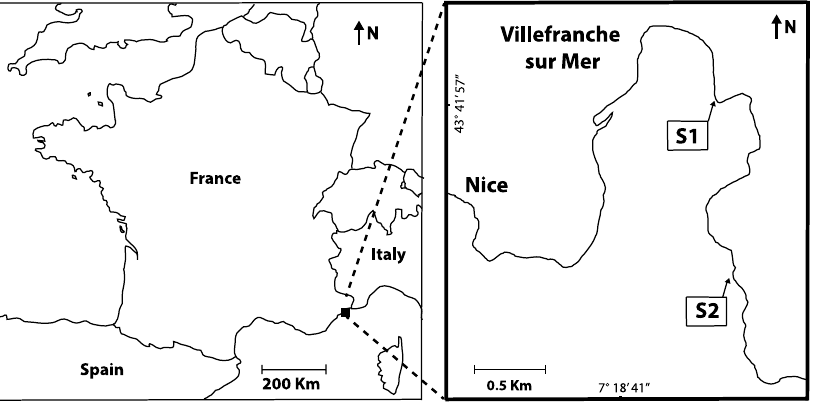
Figure 1. Study area. The two sampling sites are located in Villefranche Bay, French Riviera, NW Mediterranean Sea. Maps were made by using Adobe ® Illustrator ® software